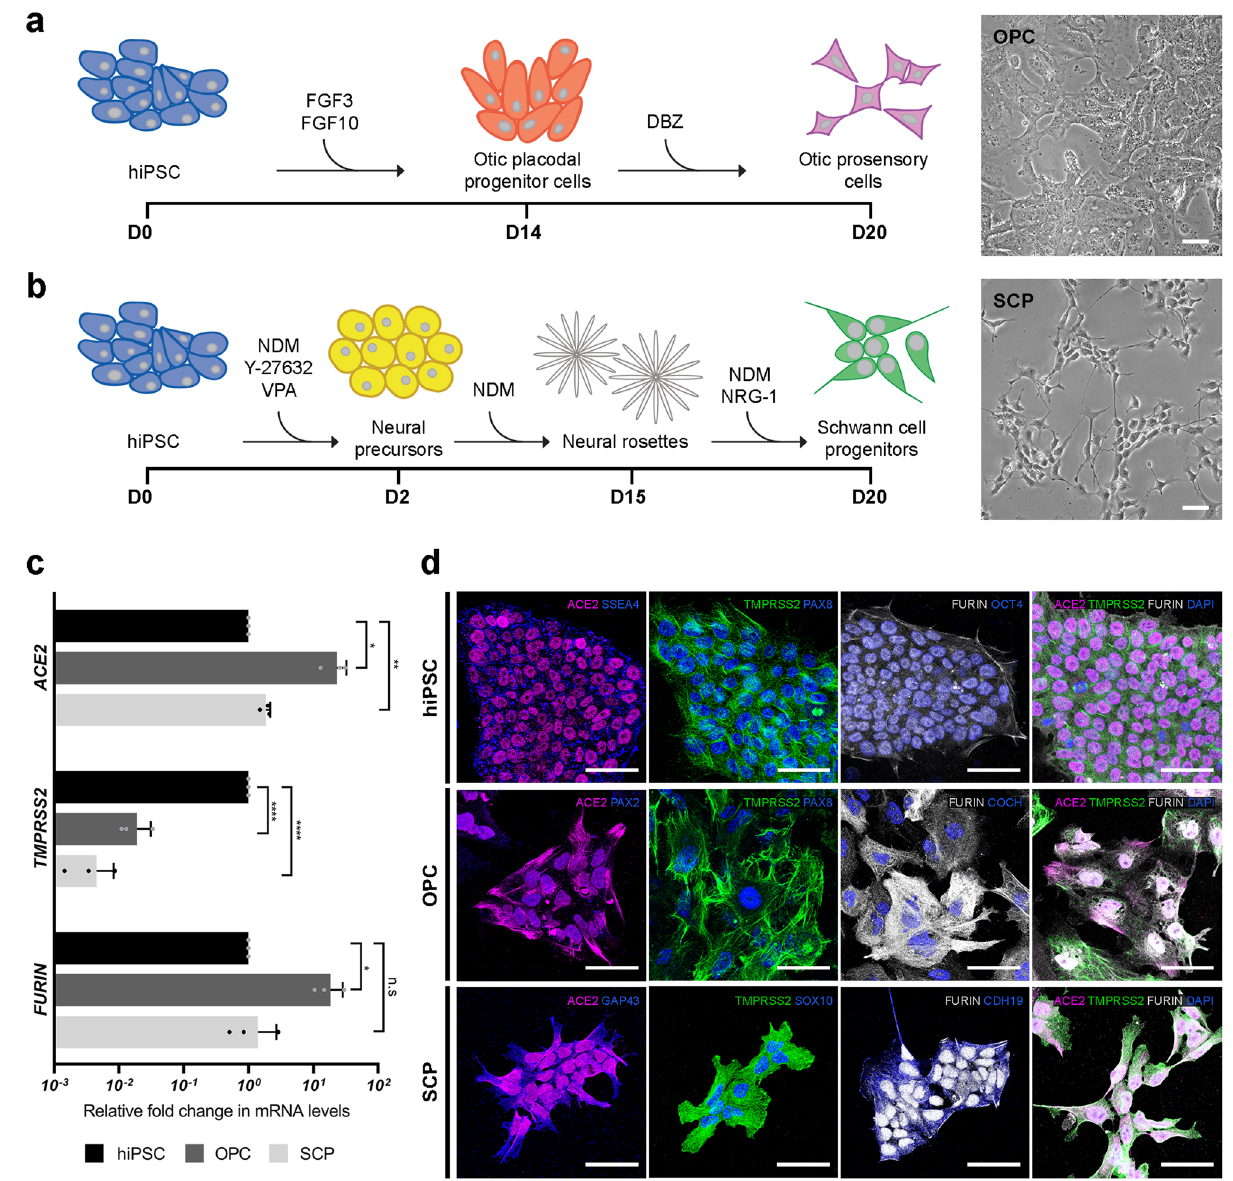
Fig. 3 Differentiation of hiPSCs into OPCs and SCPs and con fi rmation of SARS-CoV-2 cell entry-related protein expression in these cell types. a , b Scheme illustrating the generation of OPCs and SCPs from hiPSC and a bright- fi eld view of them. Scale bars = 50 μ m. c Expression of ACE2 , TMPRSS2 , and FURIN mRNA in OPCs and SCPs differentiated from hiPSC line UCSD112i-2-11 relative to hiPSCs. Individual gene expression levels in hiPSCs are set to 1. N = 3 biological replicates, 3 technical replicates; n.s. > 0.05, * P < 0.05, ** P < 0.01, **** P < 0.0001; mean ± SEM. d Expression of SARS-CoV-2 entry proteins together with pluripotency markers (SSEA4, OCT4, NANOG) in from hiPSC line UCSD112i-2-11, otic markers (PAX2, PAX8, COCH) in OPCs, and Schwann cell precursor markers (GAP43, SOX10, CDH19) in SCPs. Data are representative images from at least 3 independent differentiations. Scale bars = 50 μ